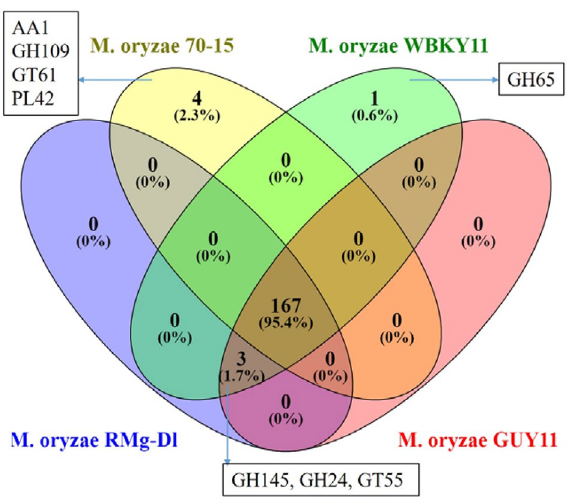
Figure 6. Identification and comparison of unique and shared CAZymes in M. oryzae RMg_Dl, M. oryzae 70-15, M. oryzae WBKY11 and M. oryzae GUY11